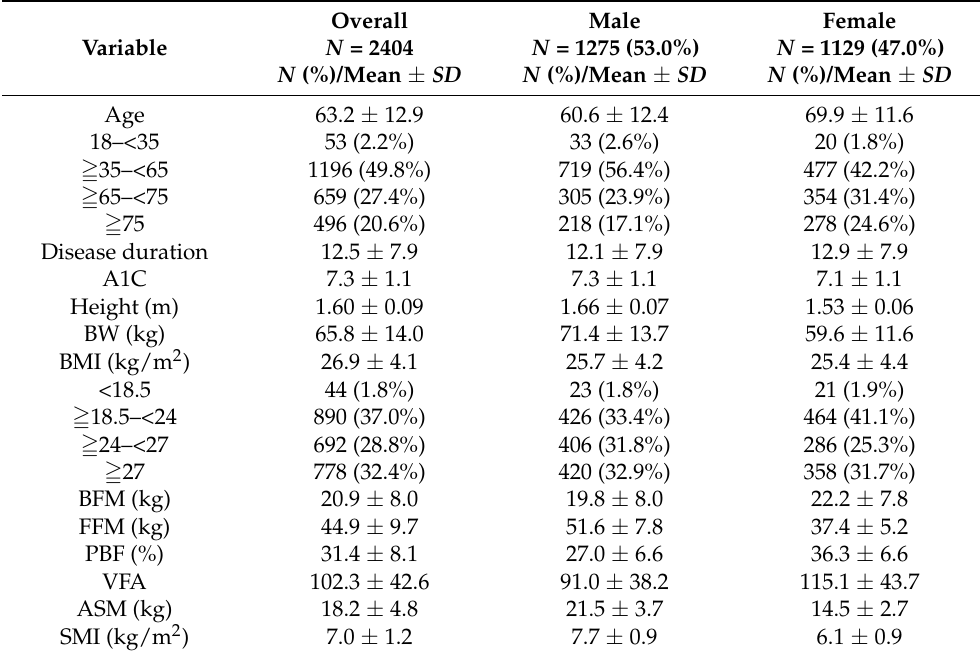
Table 1. Demographics of